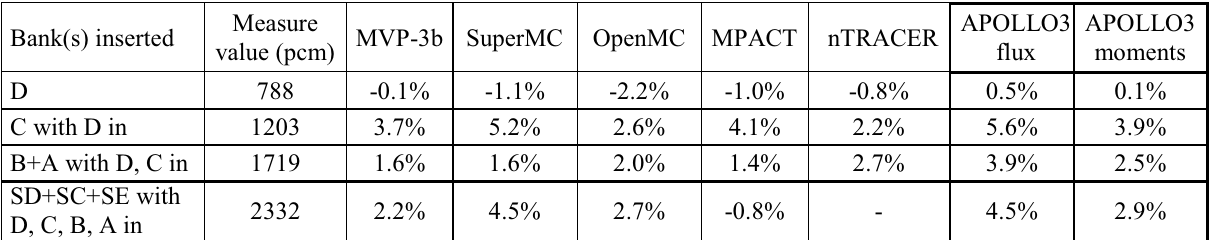
Table IV. Calculations differences with measured data for the control rod bank worths Bank(s)